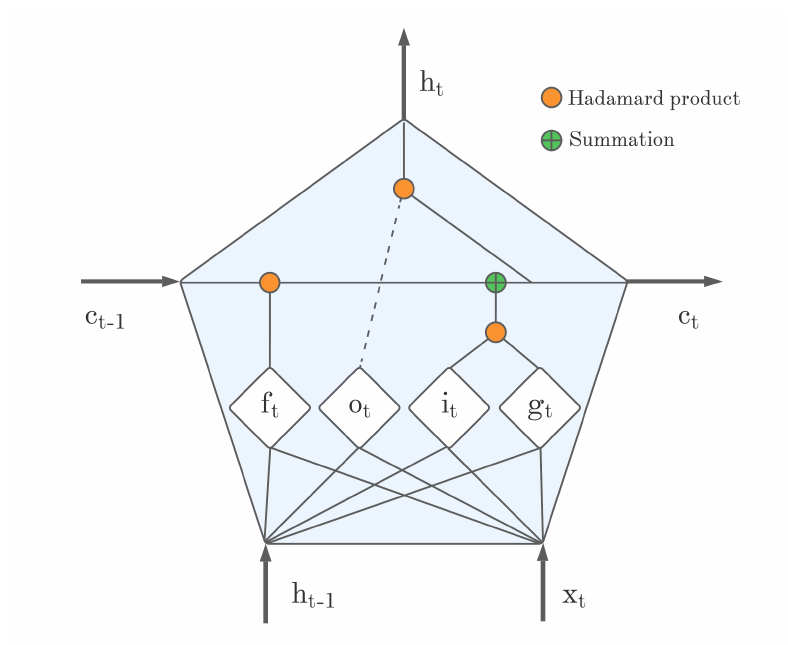
Figure 2. Schematic view of the long short-term memory